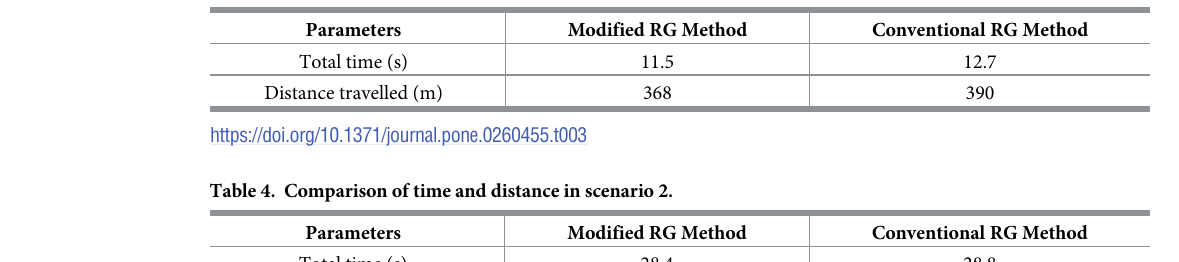
Table 3. Comparison of time and distance in scenario 1.